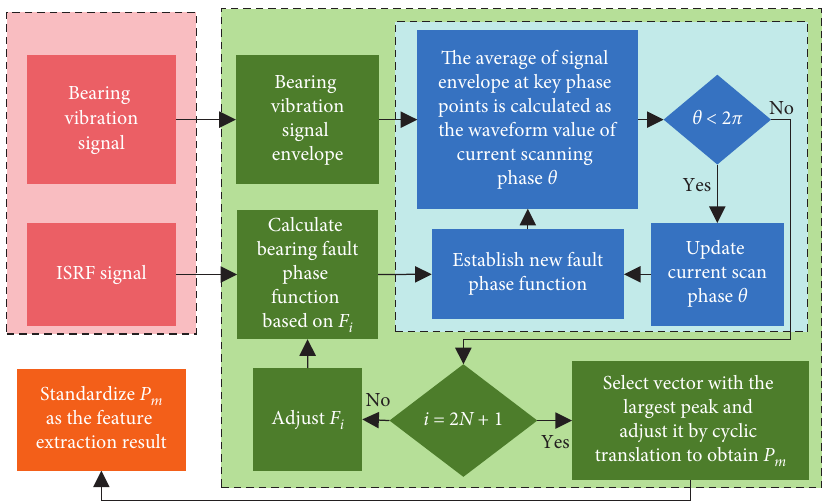
Figure 3: The flow of monopulse waveform feature